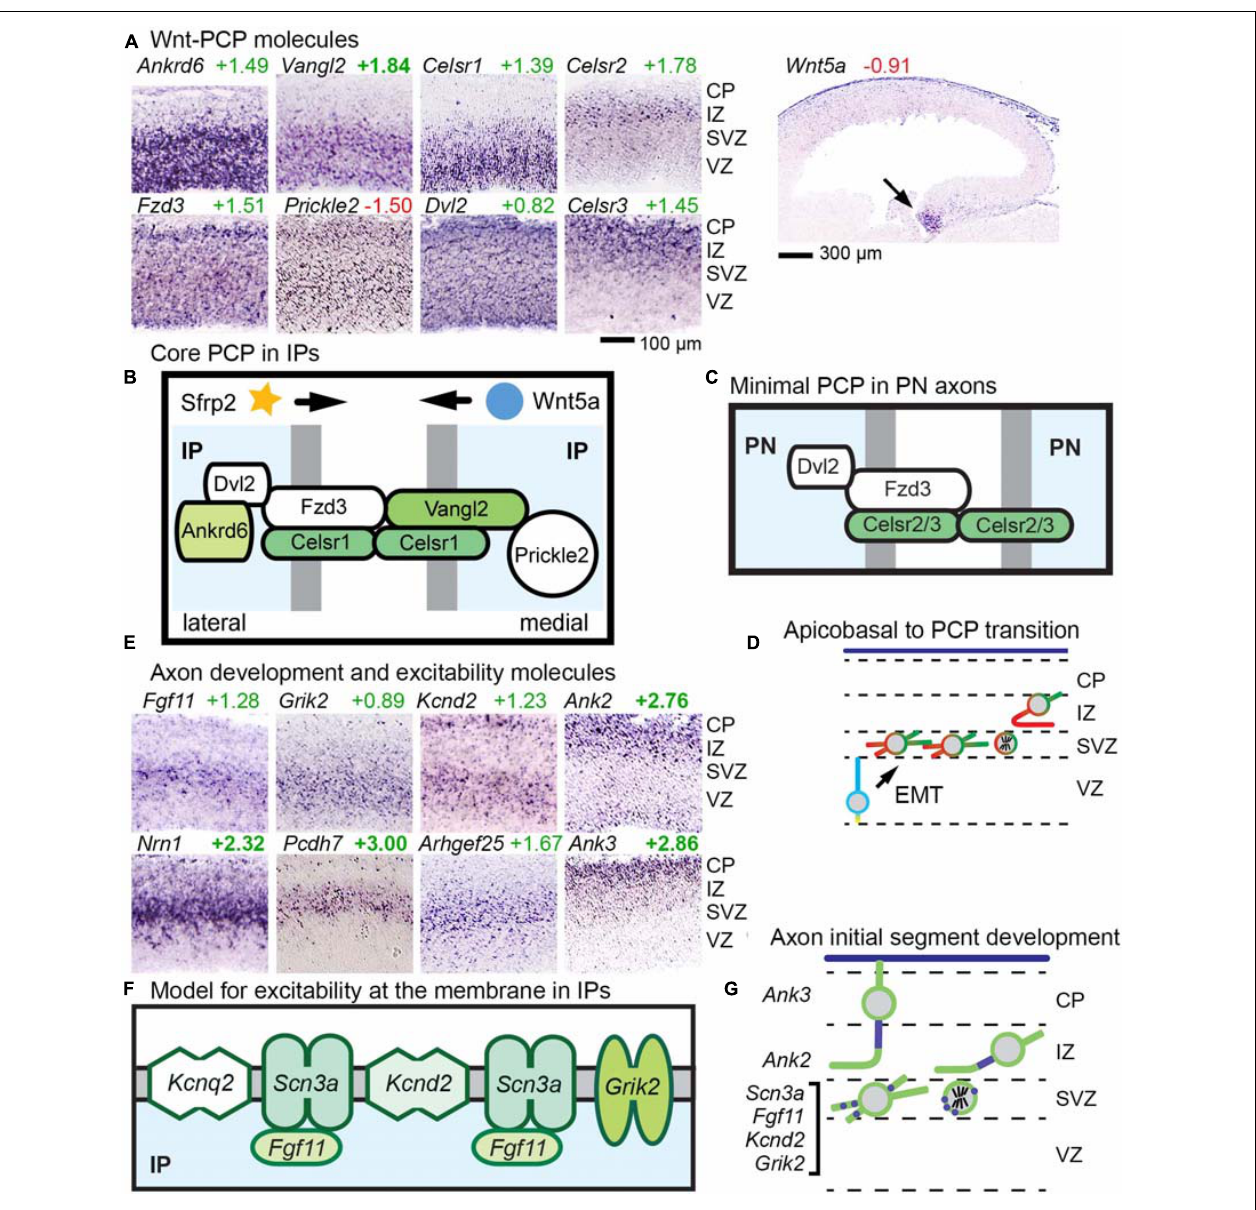
FIGURE 6 | Wnt-PCP and axon differentiation pathways in IPs. (A) Ankrd6 , Vangl2 , and Celsr1 showed IP-specific expression; Fzd3 , Prickle2 , and Dvl2 were broadly expressed; Celsr2 and Celsr3 were expressed in postmitotic PNs. (B) Proposed model of Wnt-PCP signaling complexes in IPs, possibly patterned by gradients of Wnt signaling, such as Wnt5a from the hem. Sfrp2 from the antihem might also shape Wnt gradients. Colored shapes indicate IP-selective genes, and white fill indicates widely expressed molecules. (C) Proposed model of “minimal PCP” in PNs. Unlike IPs, PNs do not produce a full complement of core PCP molecules, but do express Fzd3 , Celsr2/3 , and Dvl2 . (D) Proposed model of transition from apicobasal polarity (blue–yellow) to PCP (red–green) in aIP to bIP differentiation. In this model, PCP is initially patterned in IPs, and transmitted to postmitotic neurons in the IZ. (E) Molecules for axon development and excitability were expressed in the SVZ (including Fgf11 , Grik2 , Kcnd2 , Nrn1 , Pcdh7 , and Arhgef25 as shown), while genes for axon initial segment stabilization were expressed in postmitotic PNs ( Ank2 and Ank3 ) of the IZ and CP. (F) Proposed model of axon-like excitability patch in IPs. (G) Proposed model for the development of excitability beginning in IPs. Patches of excitable membrane may be produced in IPs, and rapidly assembled into axon initial segments in new postmitotic